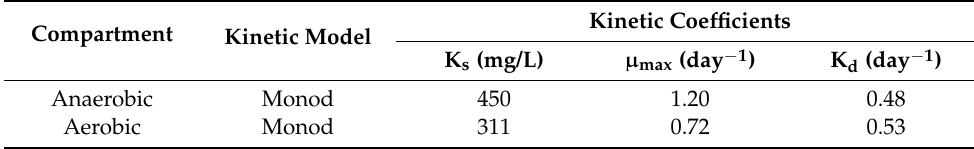
Table A3. Monod kinetic model for anaerobic and aerobic digestion for current study.